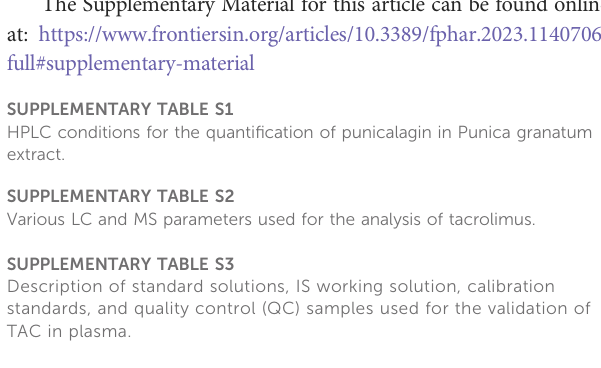
SUPPLEMENTARY TABLE S2 Various LC and MS parameters used for the analysis of tacrolimus. SUPPLEMENTARY TABLE S3 Description of standard solutions, IS working solution, calibration standards, and quality control (QC) samples used for the validation of TAC in plasma. SUPPLEMENTARY FIGURE S1 Standardization and quanti fi cation of punicalagin in PRE by HPLC